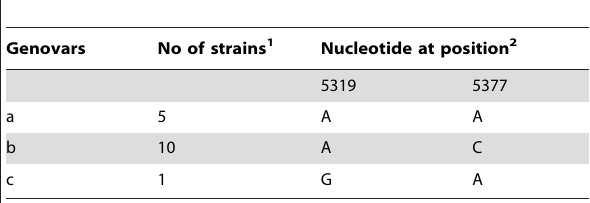
Table 3. Variable nucleotide positions and genovar definition based on the rrs-ile T IGS of 16 human and tickborne isolates of B. persica in Israel and the West Bank.